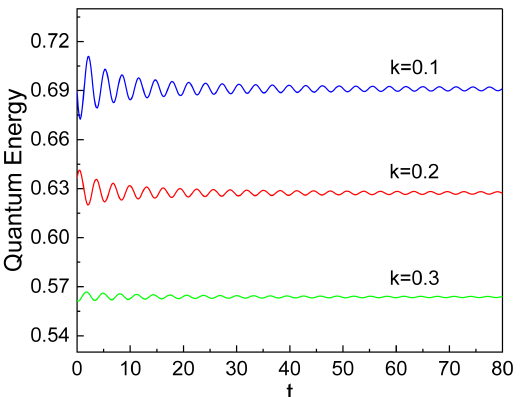
Figure 1. Quantum energy of a linearly mass-accreting oscillator with various values of k . We used